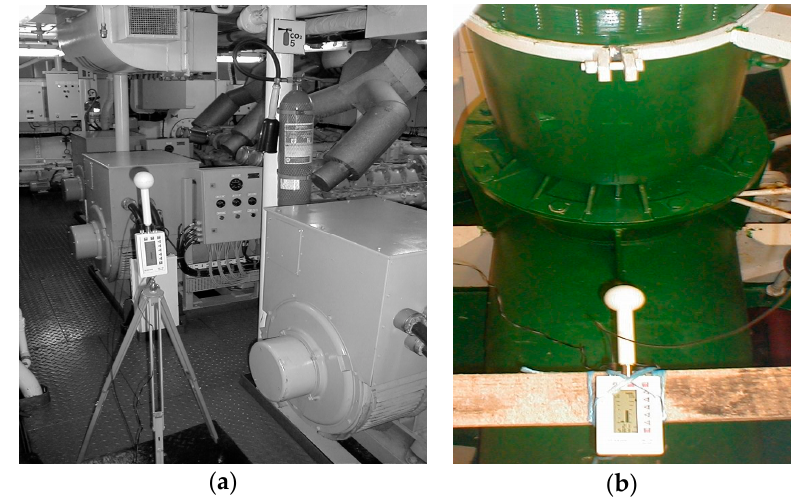
Figure 12. The measurement points: ( a ) in the ship’s engine room, close to generators No 1 and No 3 and power transformers; and ( b ) in the ship’s fore part, close to the bow thruster motor [3].